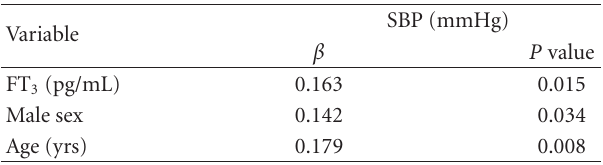
Table 3: Determinants of 24-h systolic blood pressure (SBP) in the multiple linear regression model.